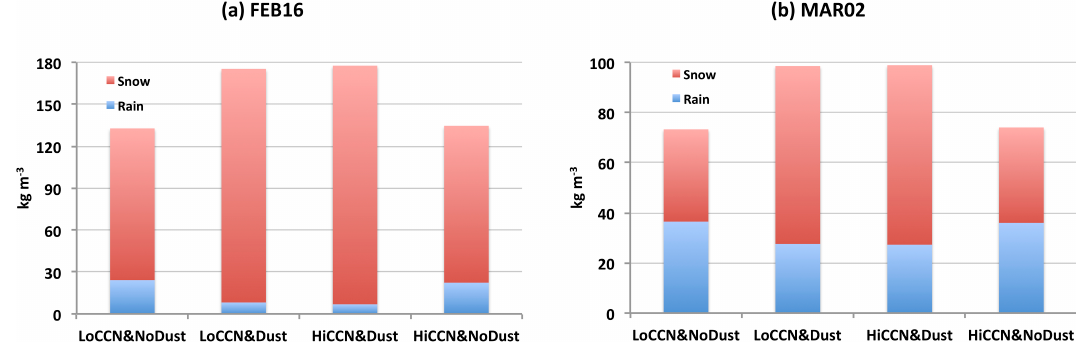
Fig. 8. Total rain (blue) and snow (red) mass concentrations at the lowest model level ( ∼ 50m above terrain height) summed over the domain 2 and during the day (00:00–23:00UTC) from all the simulations shown in x-axis for (a) FEB16 and (b) MAR02.